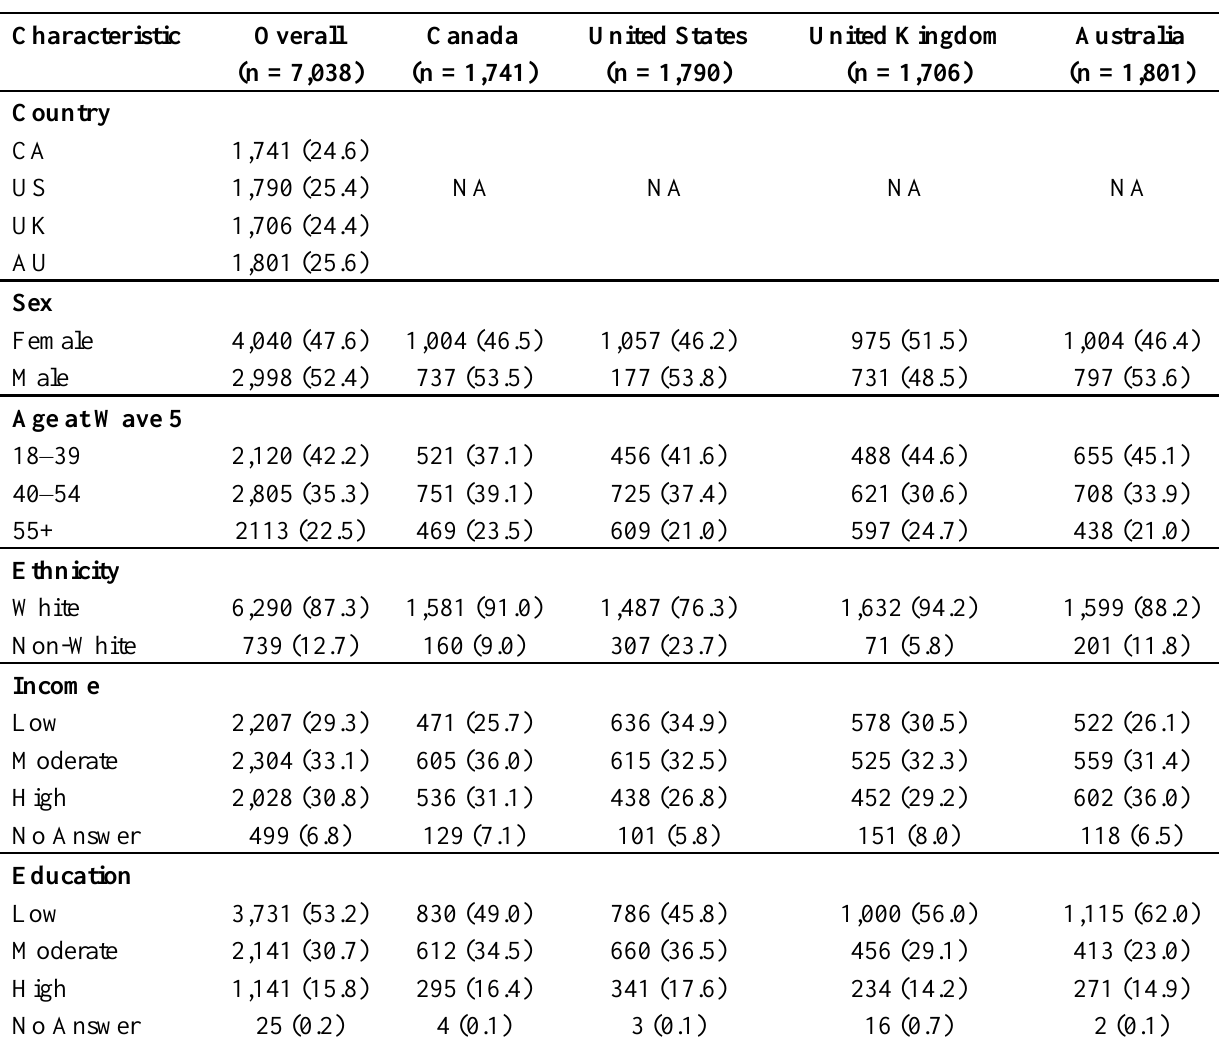
Table 1 . Demographic Characteristics of Smokers at Wave 5, Overall (n = 7,038) and stratified by country (CA: n = 1,741; US: n = 1,790; UK: n = 1,706; AU: n = 1,801) (n, weighted